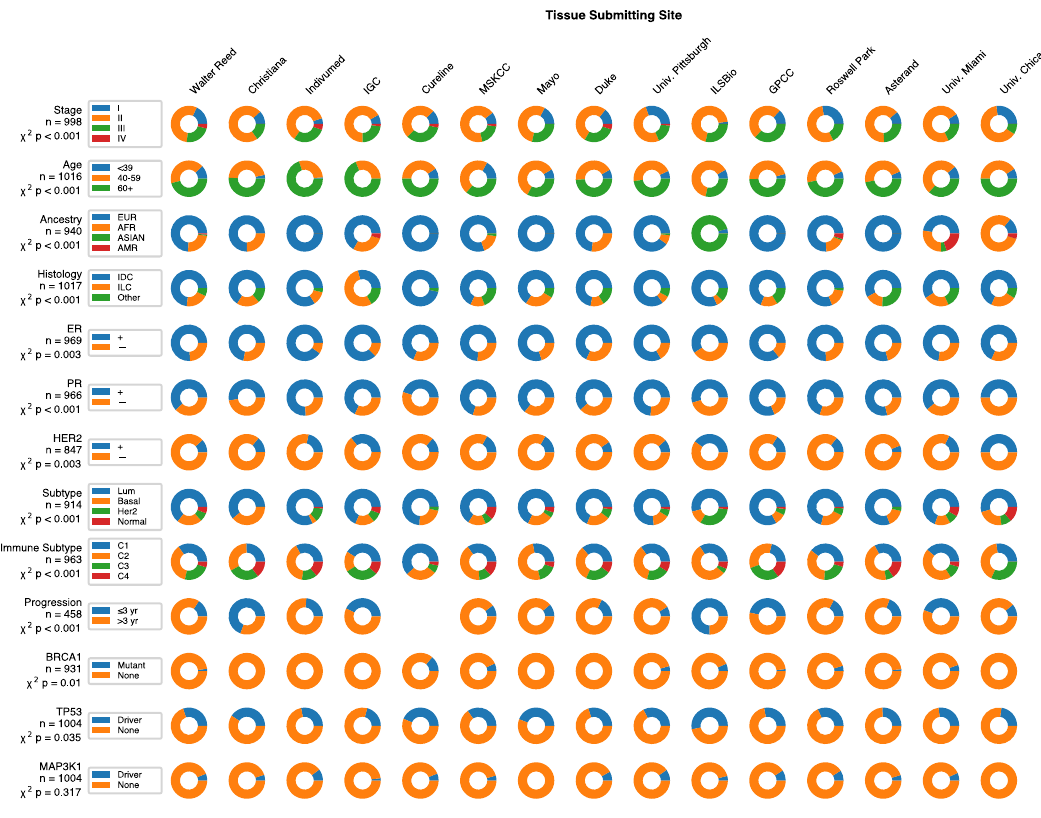
Fig. 2 Demographics and tumor characteristics of breast cancer across sites with 20 or more slides in TCGA. Each row represents a demographic, clinical, or tumor characteristic of patients in TCGA-BRCA. The chi-squared test was performed to quantify heterogeneity between sites, with the listed P values corrected for a false discovery rate of 0.05. A number of features display marked heterogeneity — for example, only two sites (ILSBio and Christiana) submitted patients where the majority had disease progression within 3 years. IGC International Genomics Consortium, MSKCC Memorial